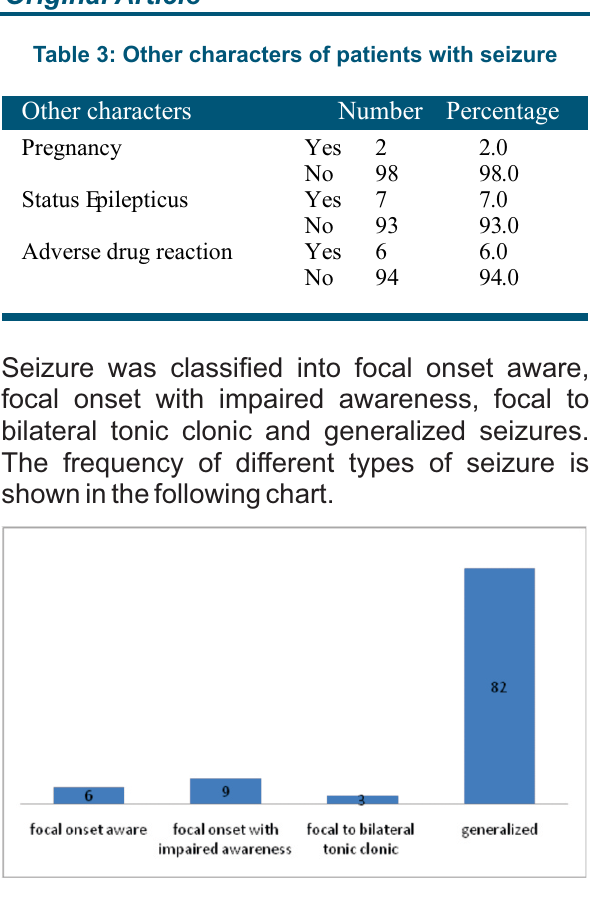
Chart 2: Distribution of seizure types